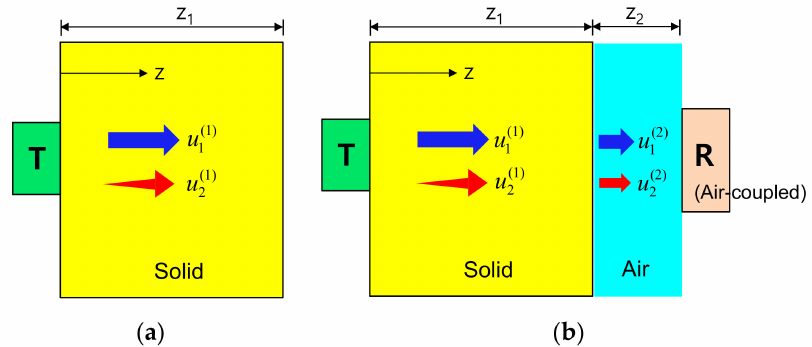
Figure 1. ( a ) Fundamental wave propagation and second harmonic generation in a solid specimen, and ( b ) Transmission at the solid-air interface, propagation in the air, and reception by an air-coupled ultrasonic